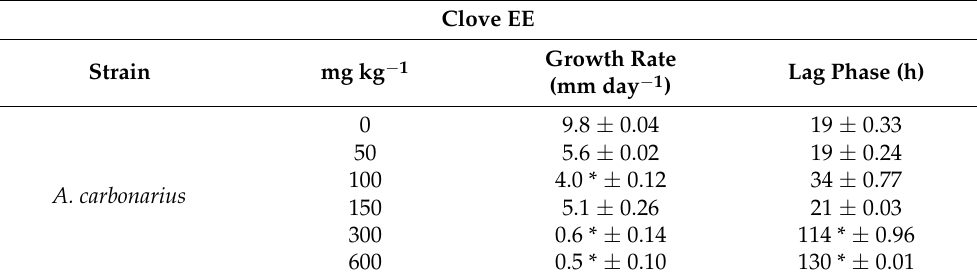
Table 9. Effect of clove ethanolic extract on lag phase and growth rate of A. carbonarius at differ- ent